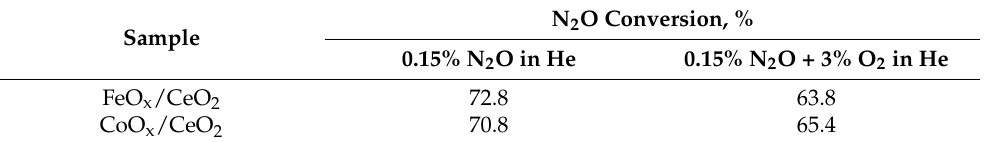
Table 3. Effect of oxygen presence in the 0.15% N 2 O in He mixture on N 2 O conversion over CeO 2 - based samples. 900 ◦